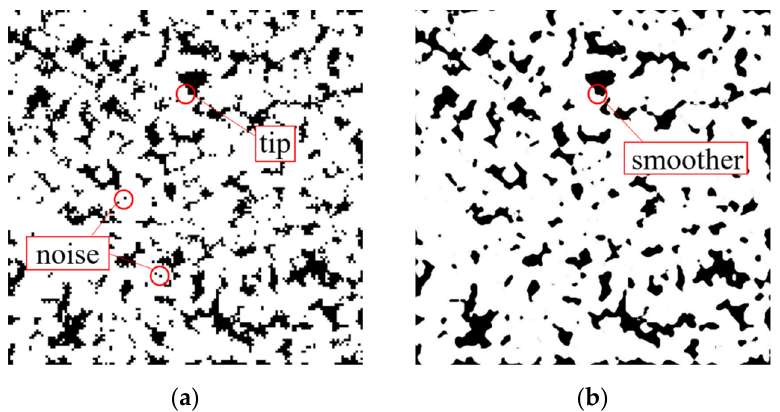
Figure 4. Slice extraction and median filtering: ( a ) Original slice map; ( b ) Median filtered image.